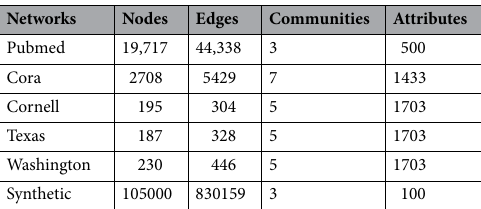
Table 1. Details of six datasets used in this